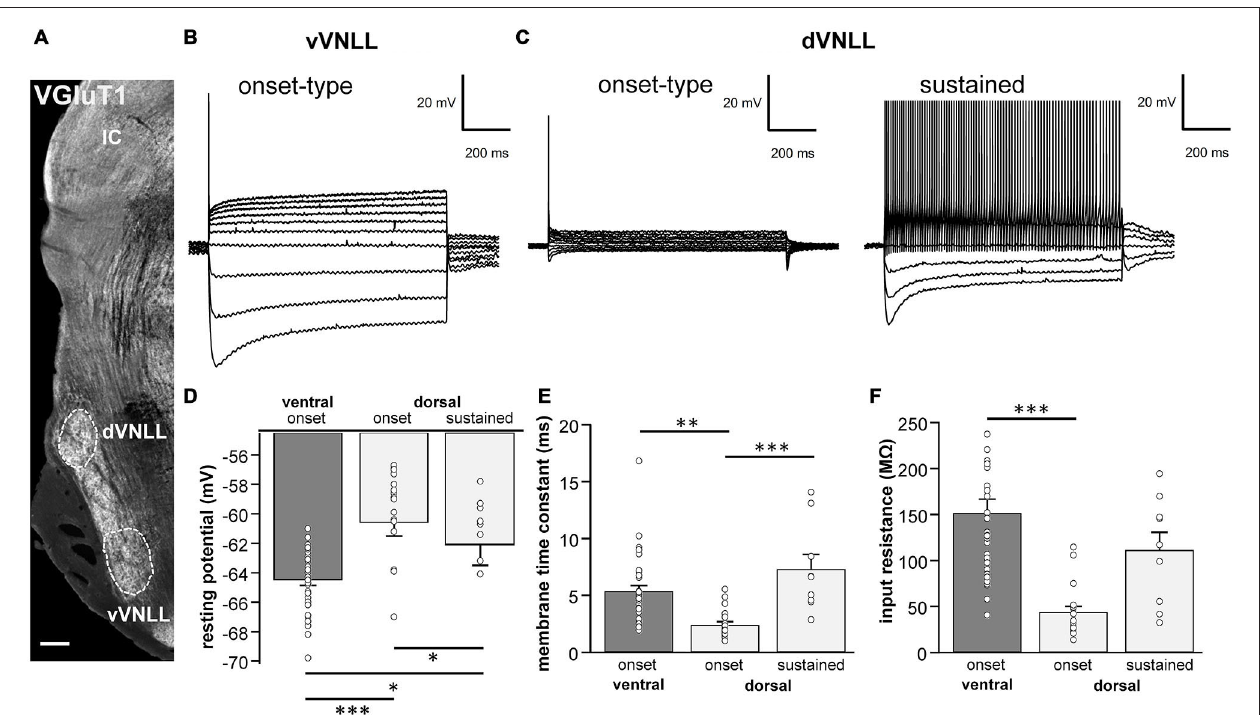
FIGURE 1 | Intrinsic properties differ between vVNLL and dVNLL neurons. (A) Low-power image with VGluT1-labeling illustrates the relative location of the VNLL within the auditory brainstem. The dorsal and ventral parts of the VNLL (dVNLL and vVNLL, respectively) are marked with a dashed line to show the respective recording sites. Scale bar: 200 µ m. (B) Representative voltage responses to hyperpolarizing and depolarizing current injections recorded from vVNLL neurons. Depolarizing current injections elicited an onset-type firing pattern in vVNLL neurons. (C) Depolarizing current injections elicited different types of firing patterns in dVNLL neurons: onset-type (left) and sustained (right) firing pattern. (D) Resting potential, (E) membrane time constant and (F) peak input resistance for vVNLL and dVNLL neurons. dVNLL: onset-type n = 19, sustained n = 9, vVNLL: onset-type n = 34. Data are obtained from twelve C57/Bl6J mice. Statistical significance was determined by a single-factor ANOVA test followed by a Scheffé’s post hoc test; ∗ p < 0.05, ∗∗ p < 0.01, ∗∗∗ p <